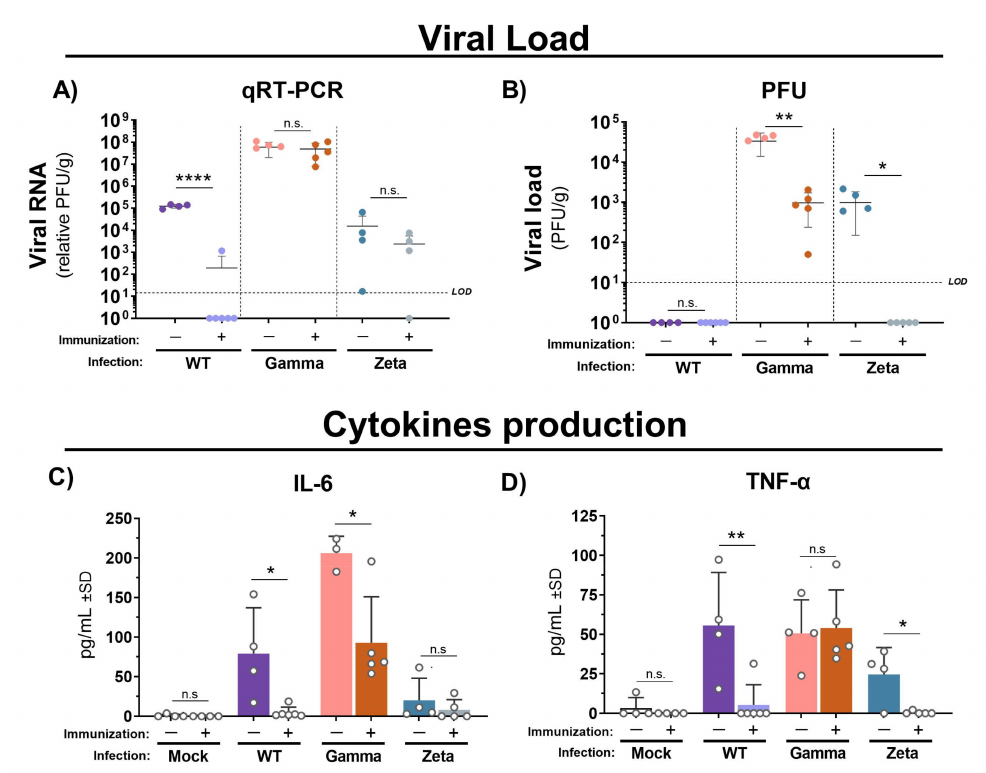
Figure 4. Viral loads and cytokine production in lungs of immunized and nonimmunized mice after infection with WT SARS-CoV-2, Gamma, or Zeta viral lineage. Three days after viral infection, the left lung was weighted and homogenized, and the supernatant was used for viral load determination by ( A ) qRT-PCR and ( B ) PFU. Cytokine production of ( C ) IL-6 and ( D ) TNF- α . Number of mice per group indicated by circles. Unpaired t -test performed between groups infected with same viral lineage. * p < 0.05; ** p < 0.01; **** p < 0.0001). LOD = limit of detection; qRT-PCR = quantitative real-time polymerase chain reaction; PFU = plaque forming unit; g = gram of tissue; n.s. = not statistically